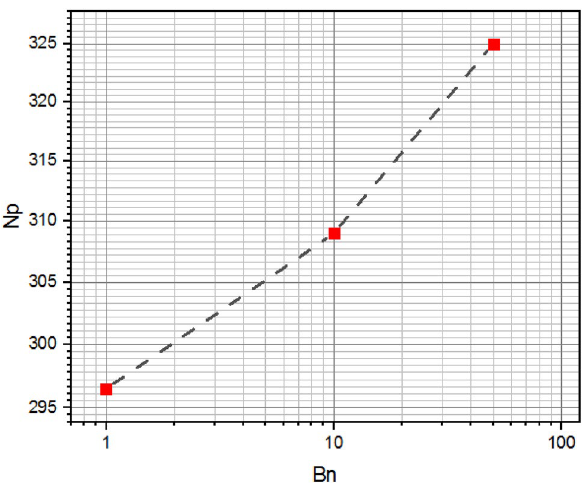
Figure 23. Power consumption versus Bingham